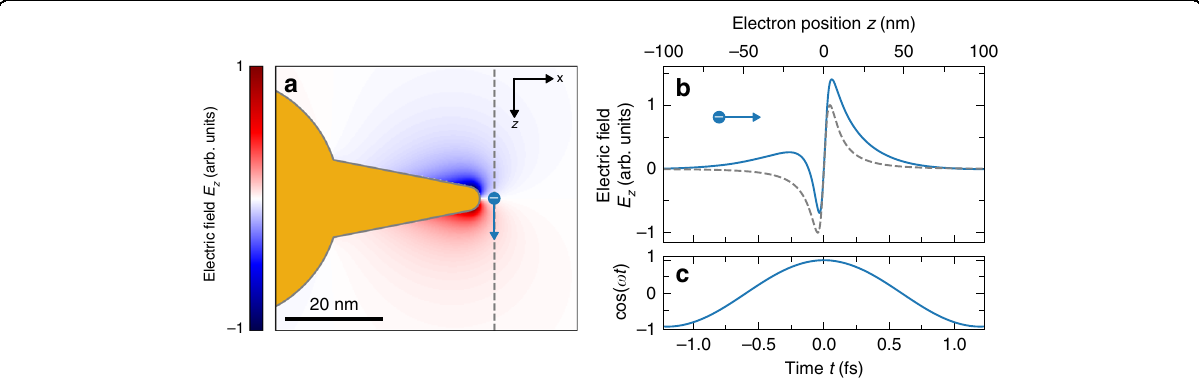
Fig. 1 Electron-near- fi eld interaction. BEM calculation of swift electron excitation of a conical Au nanotip attached to a spherical core (tip length 30 nm, cone aperture angle 22° tip apex radius-of-curvature 2.5 nm, core diameter 50 nm). At an incident energy of 20 keV, the electron passes 3 nm away from the tip apex along the dashed line perpendicular to the symmetry axis of the tip ( z direction). a Frozen-time snapshot at a minimum electron-apex distance ( t = 0) of the z component of the electric fi eld induced upon excitation of the tip resonance at (cid:1) h ω 0 ¼ 1.73 eV. b Dashed-gray curve: fi eld pro fi le along the electron trajectory in a , with z = 0 corresponding to the tip symmetry axis. Solid-blue curve: time evolution of the fi eld as effectively experienced by the electron. c Time evolution of the optical phase of the induced fi eld oscillating at the plasmon resonance frequency ω